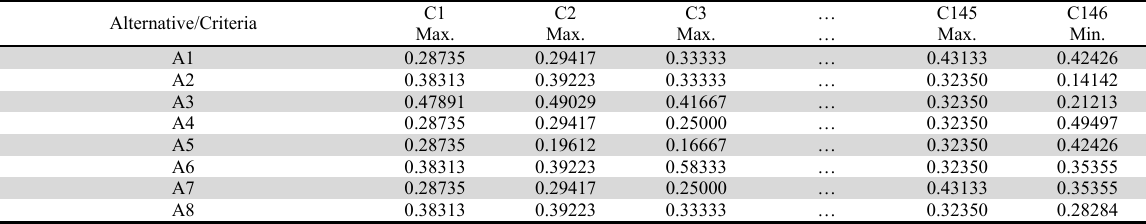
Normalize decision-making matrix